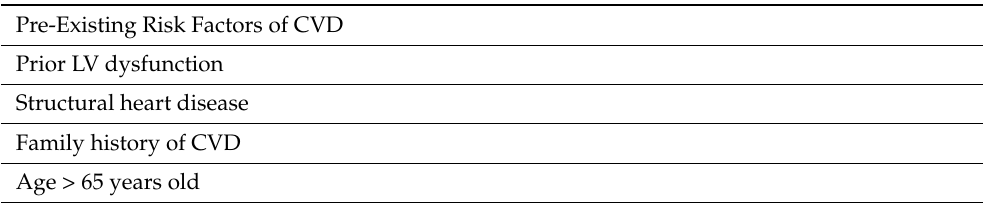
Table 2. Pathological conditions leading CCS to higher risk of subsequent development of CVD after